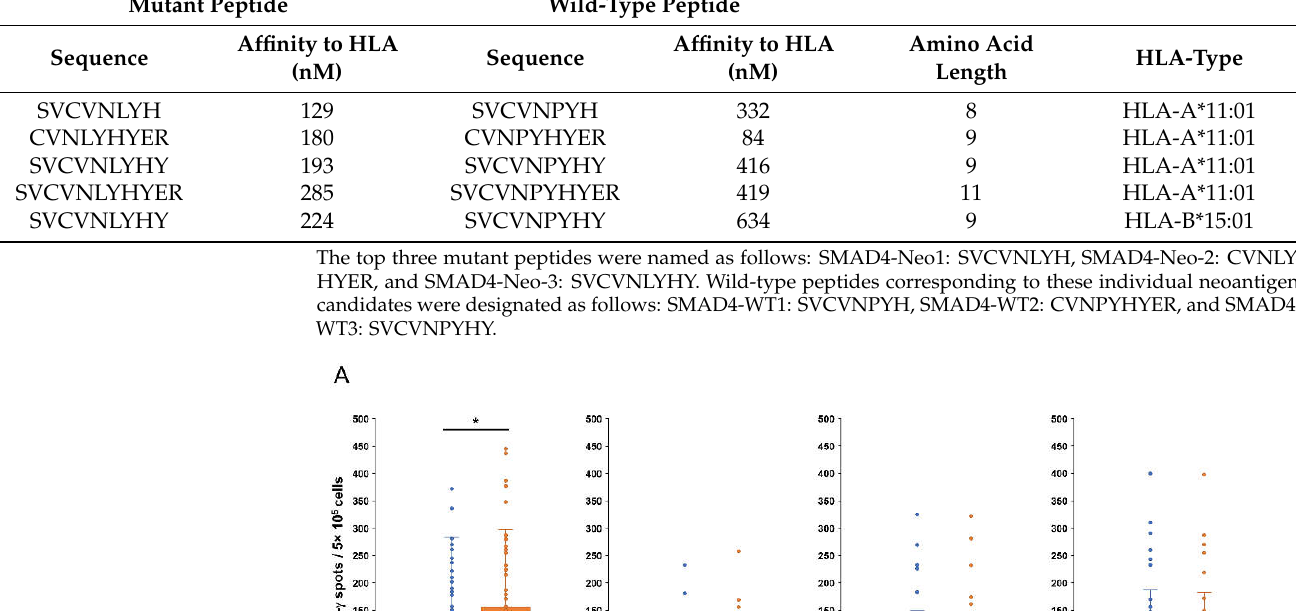
Table 1. Top five predicted SMAD4 P130L neoantigens to HLA class I. Mutant Peptide